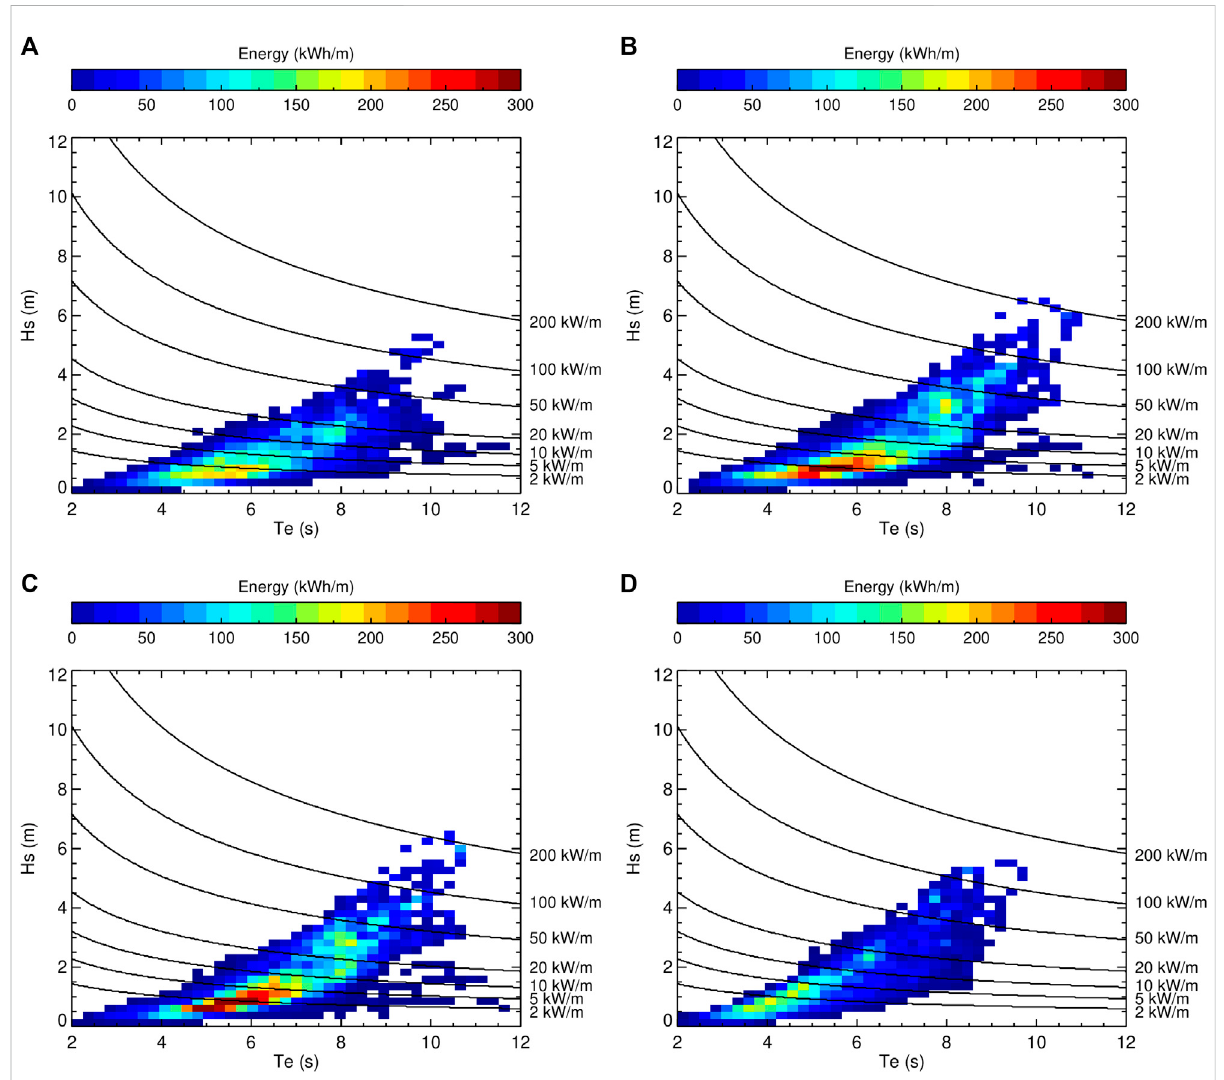
FIGURE 13 Distributionofaverageannualwaveenergyasafunctionofsigni fi cantwaveperiodandsigni fi cantwaveheight,forsitesCY-1 (A) ,CY-2 (B) ,CY-3 (C) , CY-4 (D) , of Figure 11. Dotted lines mark reference power